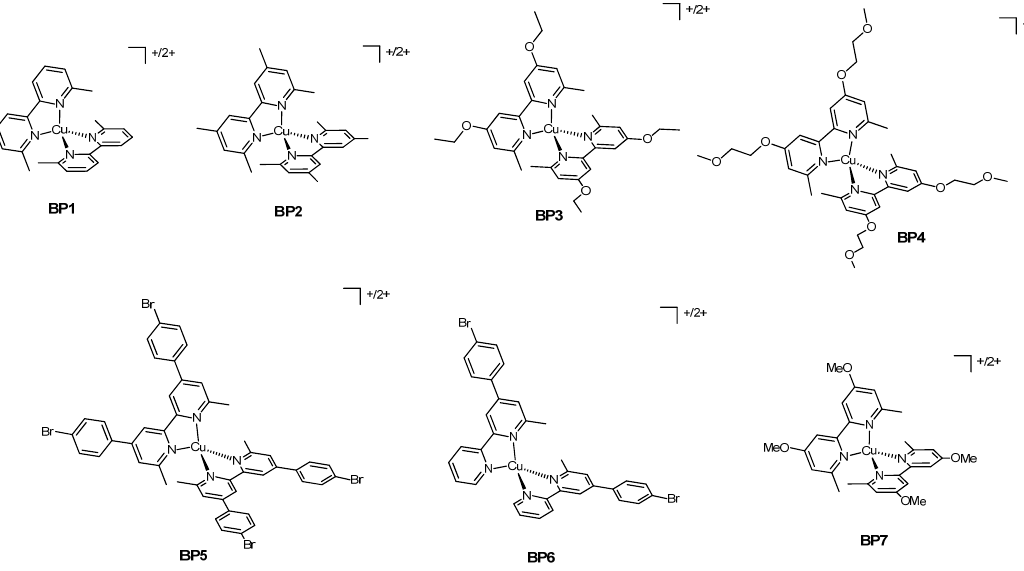
Figure 6. The bipyridine copper complexes employed as redox